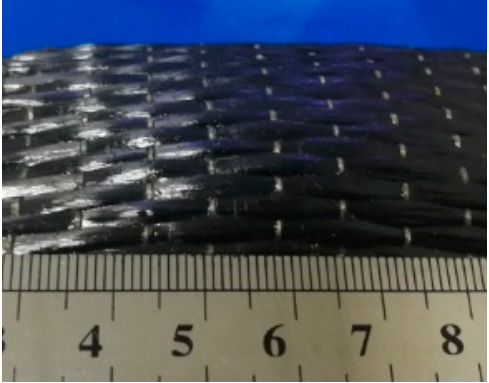
Figure 6. The defect of fiber displacement warping of 2D-T700/E44 composite prepared by ICM.